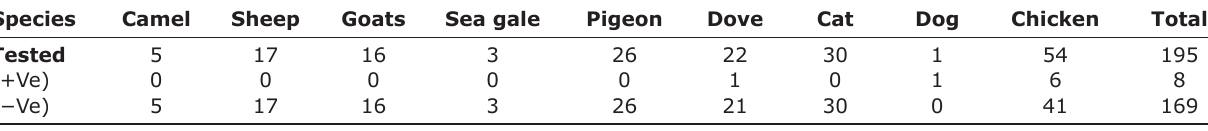
Table-1: Results of the serosurveillance of influenza type A virus in some animals and birds in Eastern Saudi Arabia. Species Camel Sheep Goats Sea gale Pigeon Dove Tested